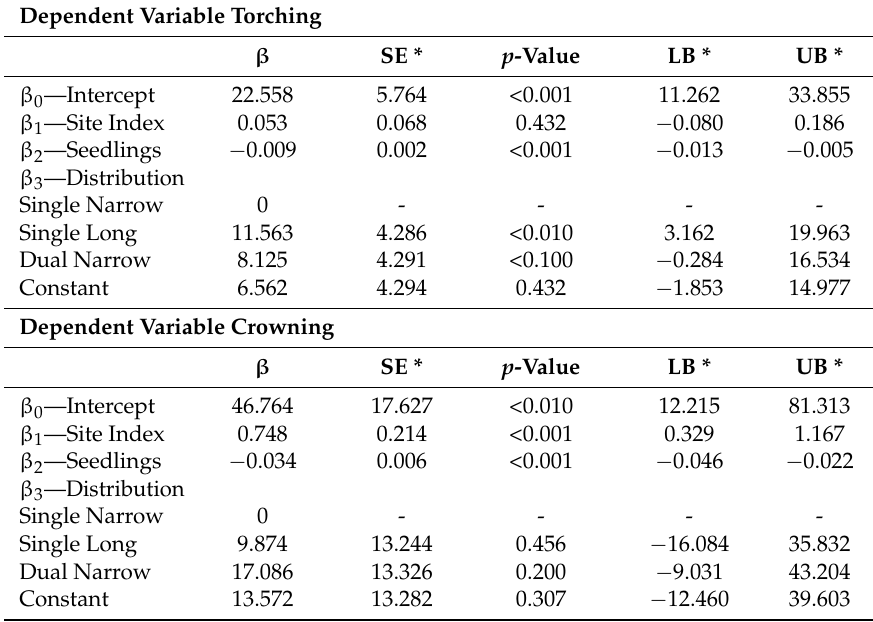
Table 3. Tobit analysis regression coefficients ( β ) for predicting the dependent values of time to return to within 10% of pre-treatment Torching and Crowning Indices using the Single Narrow Distribution as the base distribution (Equation